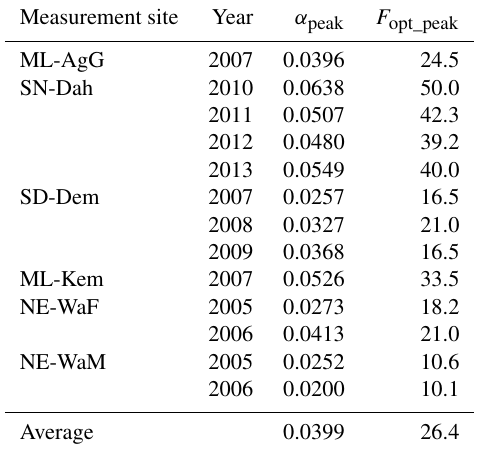
Table 4. Annual peak values of quantum efficiency ( α peak ;µmolCO 2 µmolPAR − 1 ) and photosynthetic capacity ( F opt_peak ;µmolCO 2 m − 2 s − 1 ) for the six measurement sites (Fig. 1). The peak values are the 2-week running mean with highest annual value.